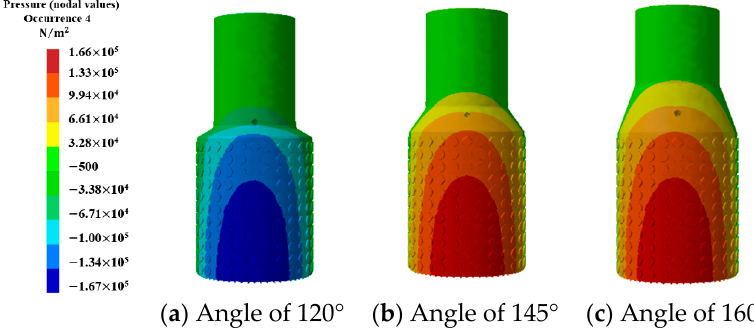
Figure 11. Fourth-order acoustic cavity modality.